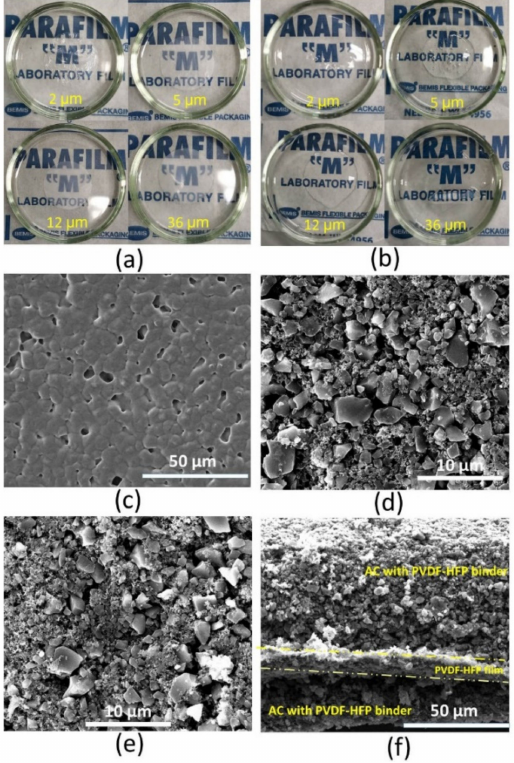
Figure 1. Photographs of PVDF-HFP films of various thicknesses: ( a ) dry films and ( b ) films soaked with 1 M TEABF 4 in acetonitrile. SEM images: ( c ) 12 µ m PVDF-HFP film, ( d ) activated carbon